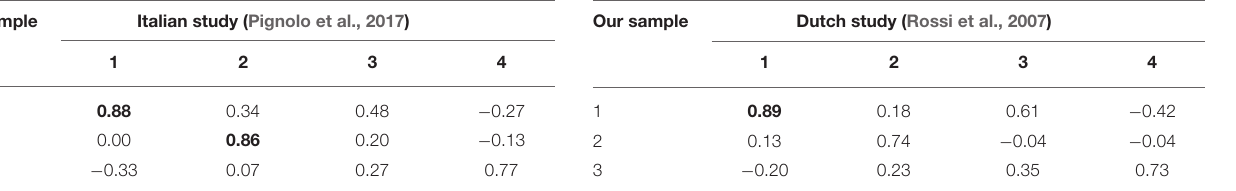
TABLE 12 | Coefficients of congruence ( 8 ) between factors of our sample and Dutch study (Rossi et al., 2007), using the principal component analysis (PCA). Our